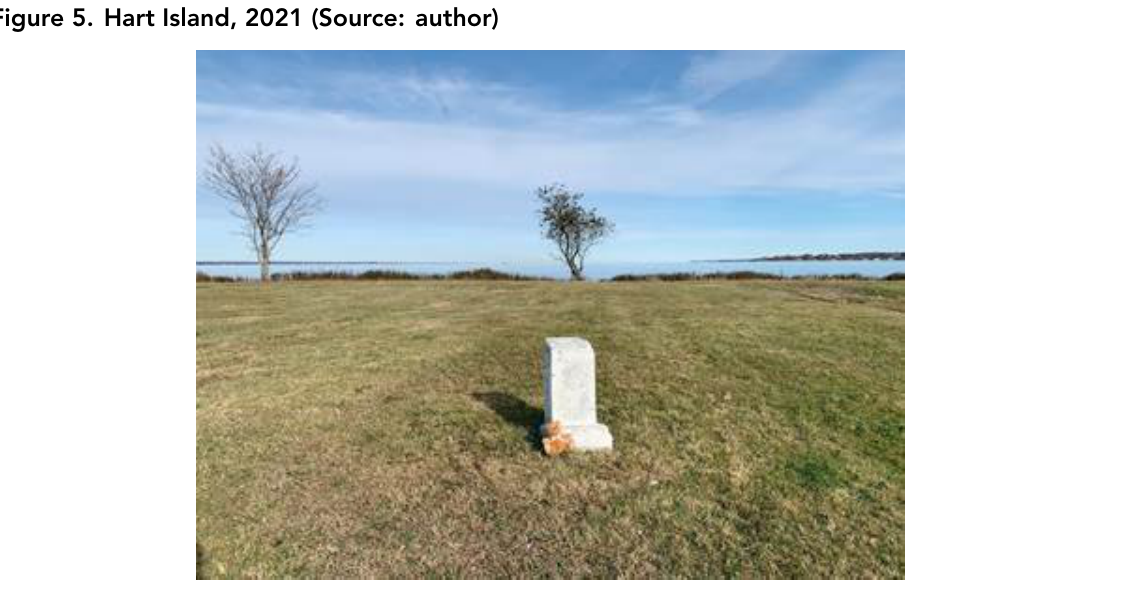
Figure 5. Hart Island, 2021 (Source: